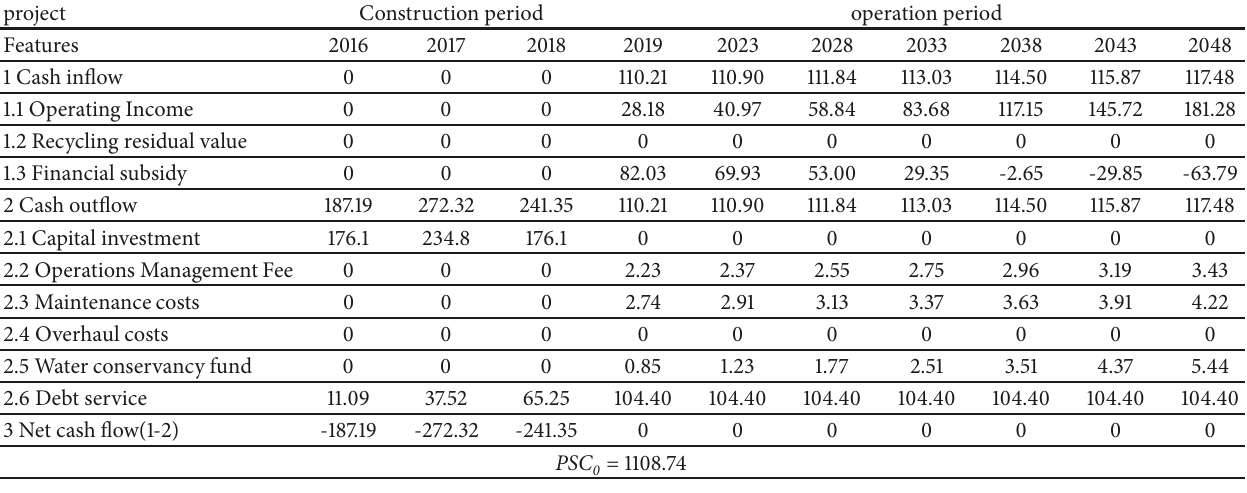
value, unit: million Yuan. 0